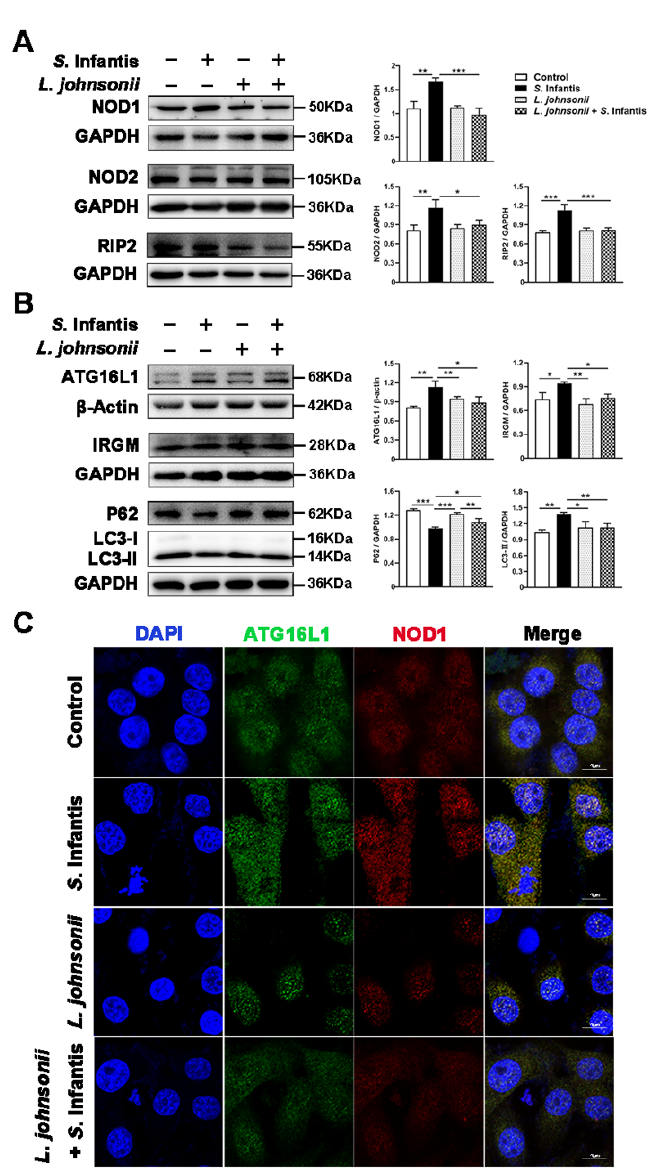
Figure 3. L. johnsonii L531 alleviates recruitment of ATG16L1 triggered autophagy by NOD1 after S . Infantis infection. ( A , B ) Western blotting analysis for NOD1, NOD2, RIP2, ATG16L1, IRGM, P62, and LC3 in Caco2 cells. The right panels show the protein quantitation using Image J software. ( C ) Confocal micrographs illustrating the accumulation of ATG16L1 (Green) and NOD1 (Red) in Caco2 cells treated with S. Infantis or L. johnsonii L531. Blue: DAPI. Scale bar, 10 µ m. Data are represented as mean ± SEM, n = 3; * p < 0.05, ** p < 0.01, *** p < 0.001.